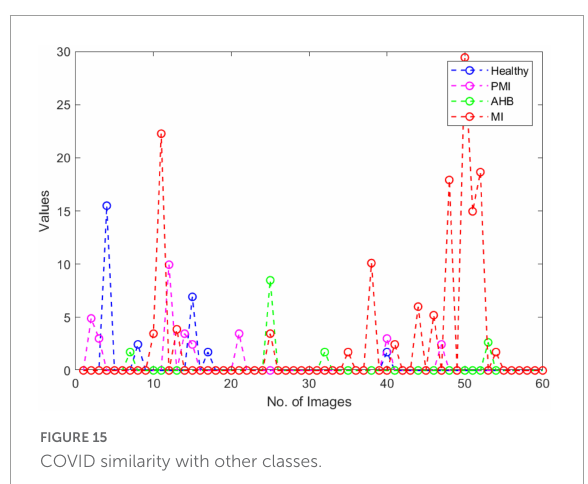
FIGURE15 COVID similarity with other classes.